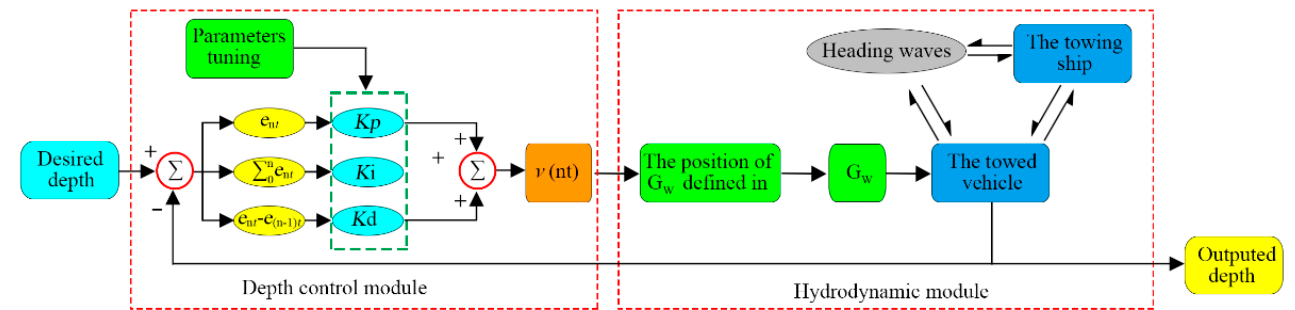
Figure 6. Simulation procedure for complete system.